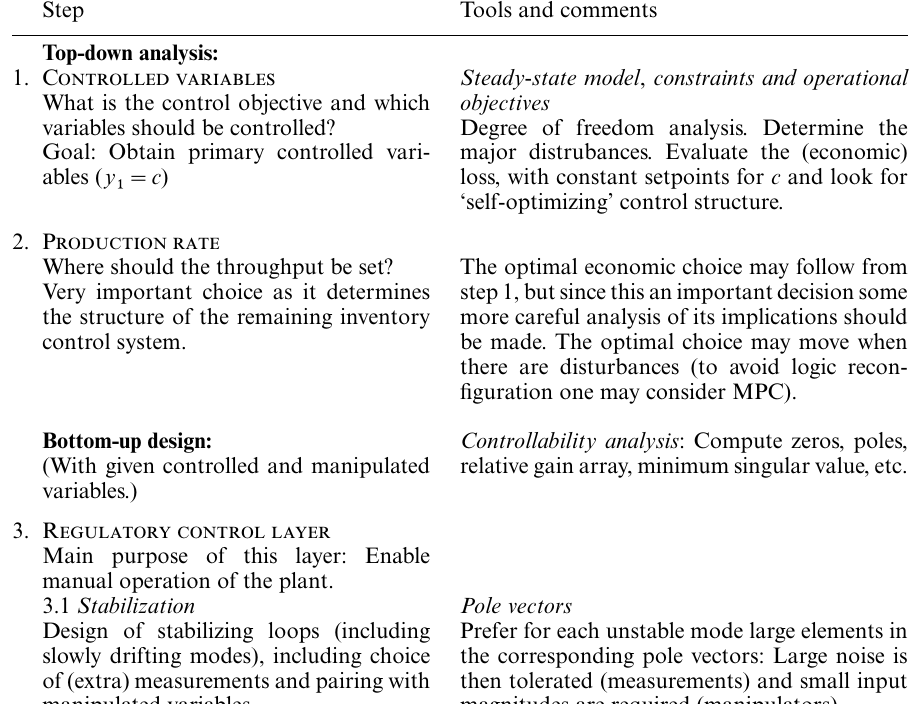
Table 1. A plantwide control design